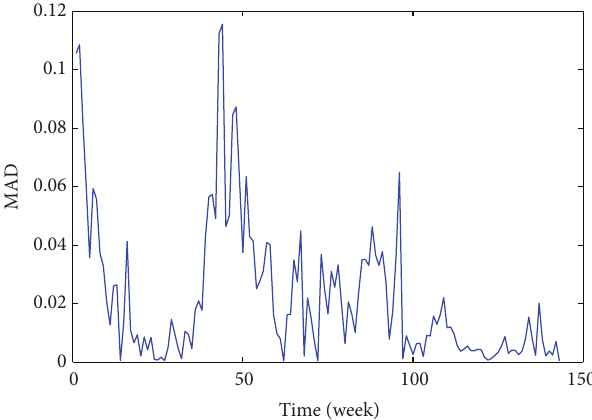
Figure 3: Comparison of theoretical prices with dynamic and static credit